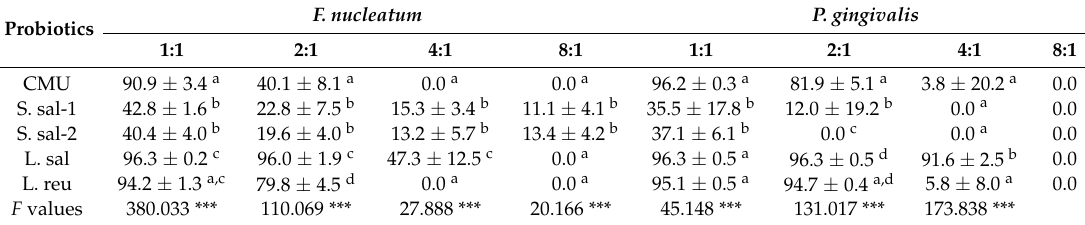
Table 4. Dose-dependent effects of oral probiotic culture supernatants on the growth of periodontal bacteria, S mutans and S. sobrinus , expressed as inhibition level